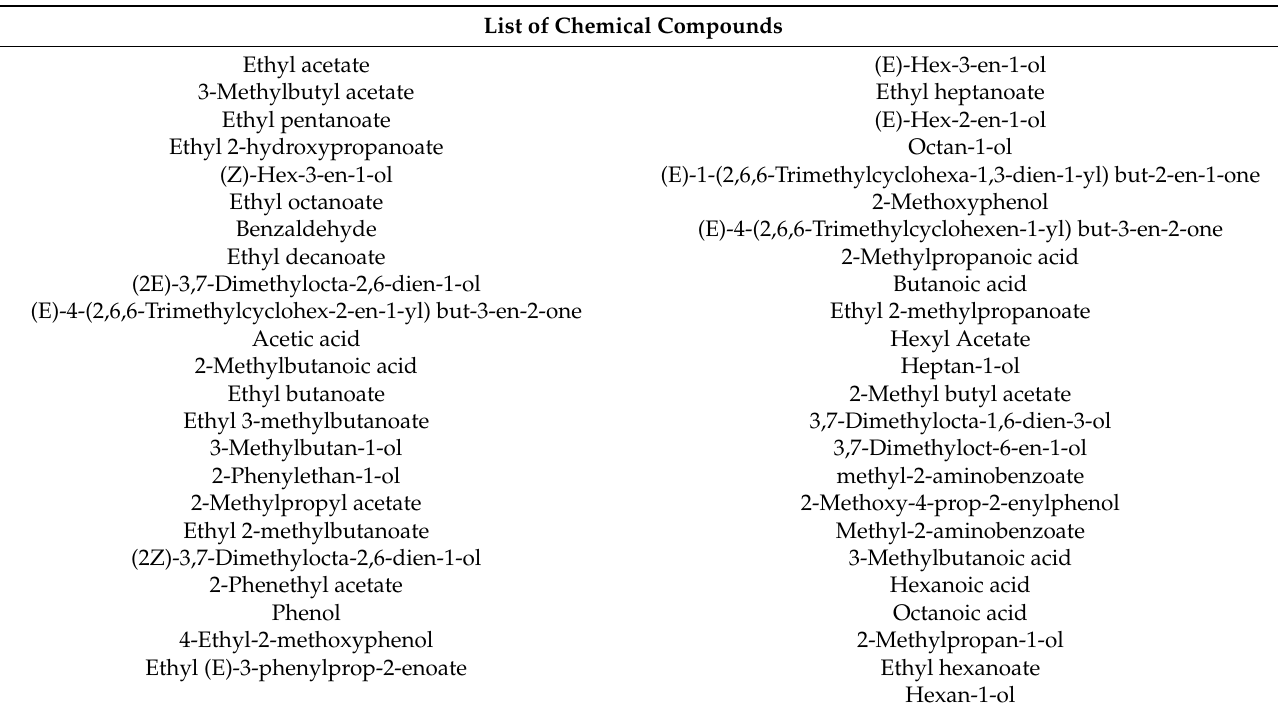
Table 4. List of 47 chemical compounds in New Zealand’s Pinot noir wine dataset1. List of Chemical